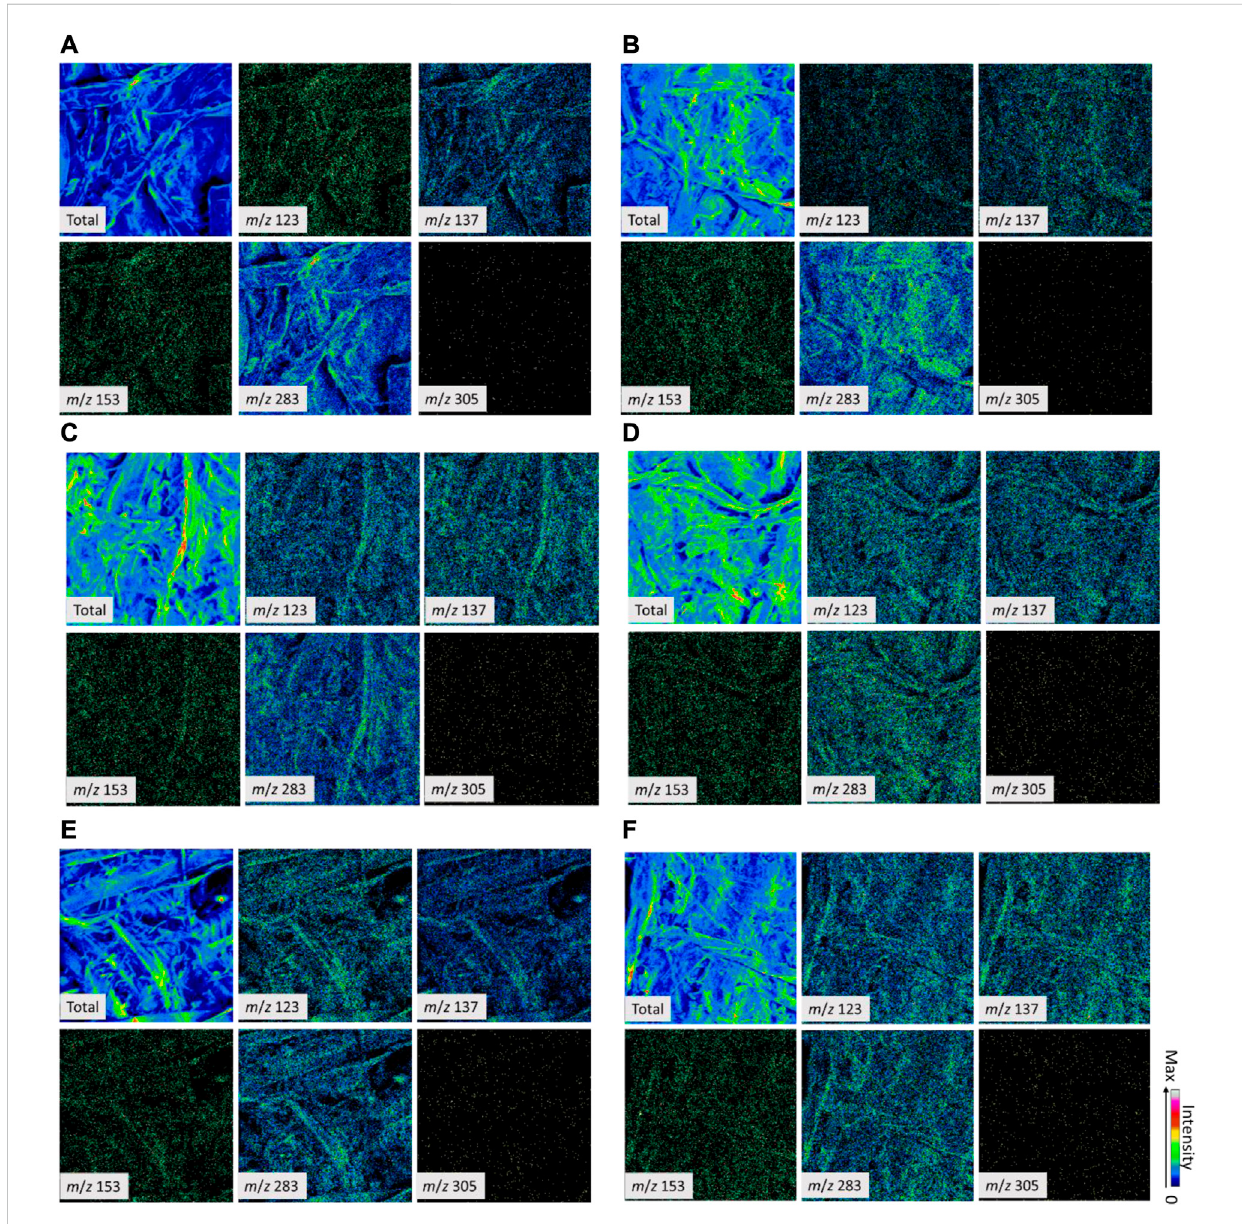
Positive ToF-SIMS images of the non-treated and tannin-rich bark extract (TW)-treated paper samples of 60 g/m 2 (A, C, E) and 130 g/m 2 (B, D, F) . The peaks generated from TW acid ( m/z 123), the surface of handsheets ( m/z 137 and 283), and candidate peaksfrom tannic acid were not presentin the samples( m/z 153and305).Totalsecondaryions(Total)representthesurfacestructuresof fi bermatrices. (A,B) :blank; (C,D) ,2%TW;andE-F,4%TW.The color scale was adjusted to 0 – 255 (8 bit) (bottom, zero; top,